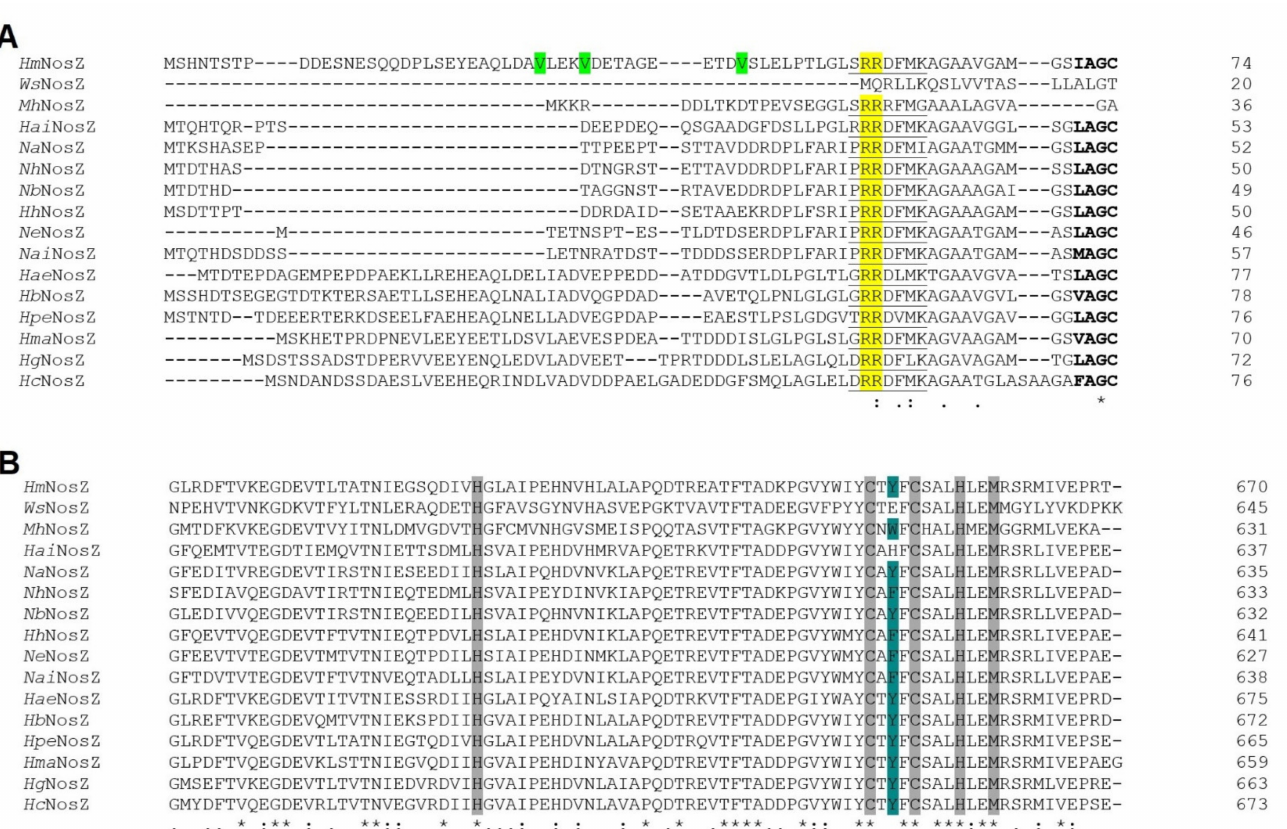
Figure 7. Clustal omega alignment of Wolinella succinogenes ( Ws NosZ; Protein NCBI ID: WP_129545366.1), Marinobac- ter hydrocarbonoclasticus ( Mh NosZ; Protein NCBI ID: WP_039373687.1), Halorubrum aidingense ( Hai NirK; Protein NCBI